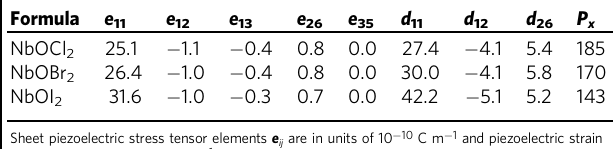
Table 2 Piezoelectric tensor elements and spontaneous polarizations of NbOX 2 .